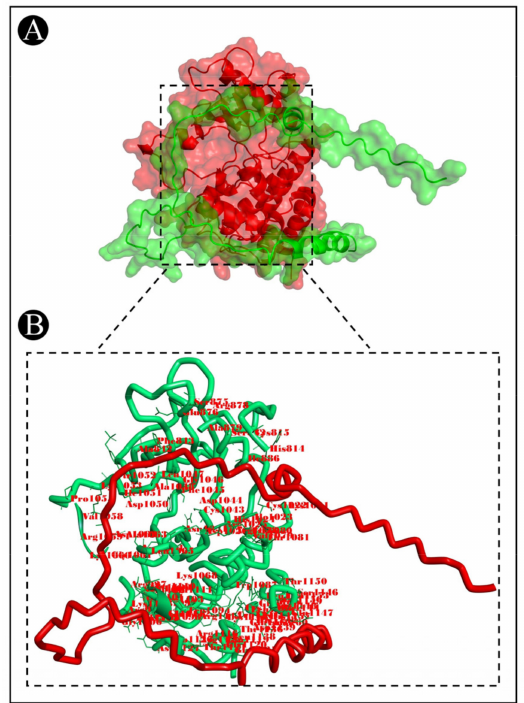
Figure 8. Docking representation of acidocin A and 2OH4 complex. ( A ) The binding interface of the complex, ( B ) the binding interaction between the amino